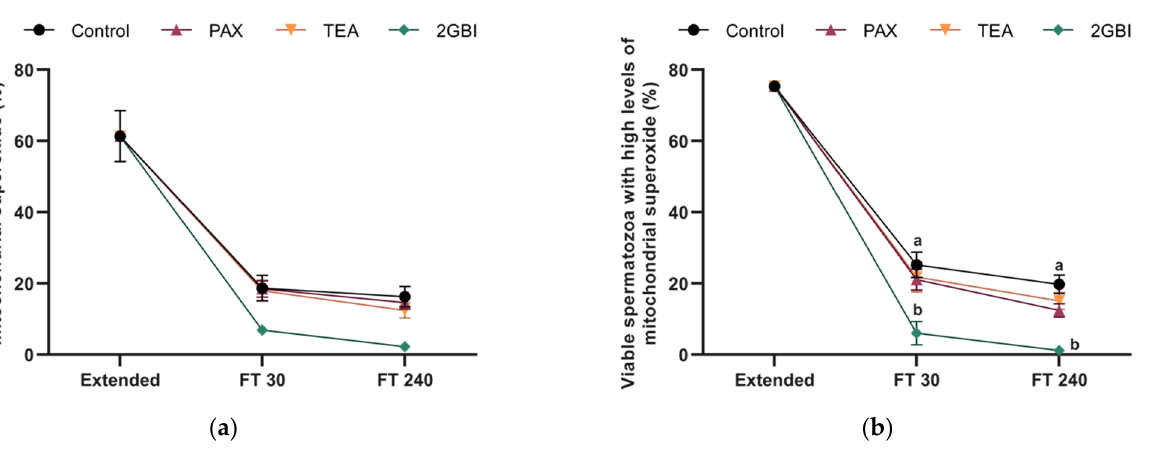
within the same time point. Results are given as mean ± SEM.